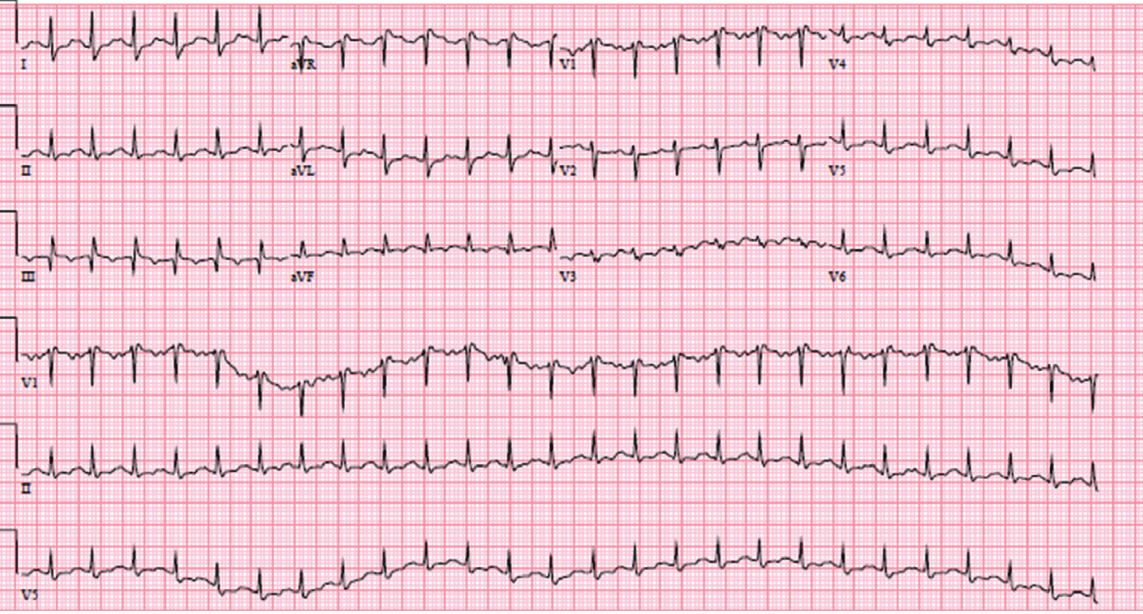
Figure 2: Electrocardiogram.